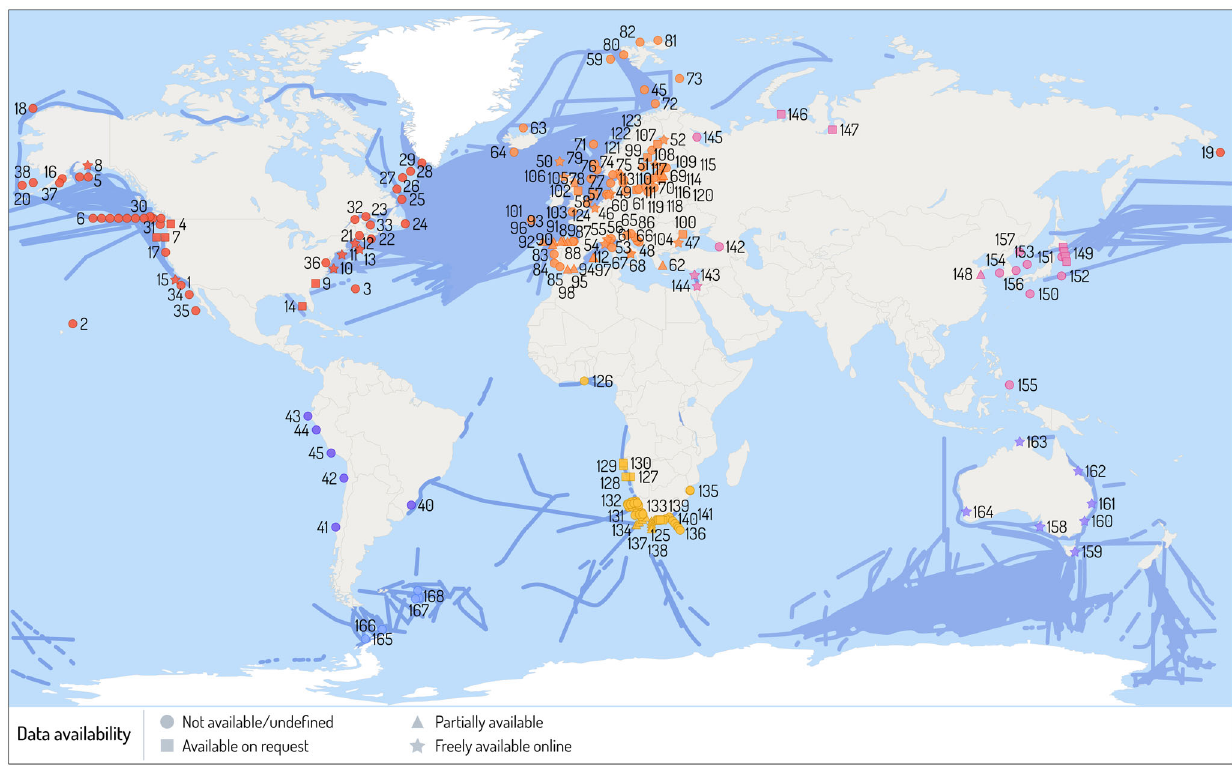
Fig. 3 | Map of long-term monitoring programmes for zooplankton in the globalocean. BluelinesindicateContinuousPlanktonRecorder(CPR)surveysand symbols indicate sites of speci fi c long-term monitoring programmes (see Supple- mentary Data 1 fordetails ofnumbered sites).Stars indicate data is freely available todownload,squaresindicatedataavailableonrequest,triangleindicatespartially available, and circles indicate data either not available or unclear on data